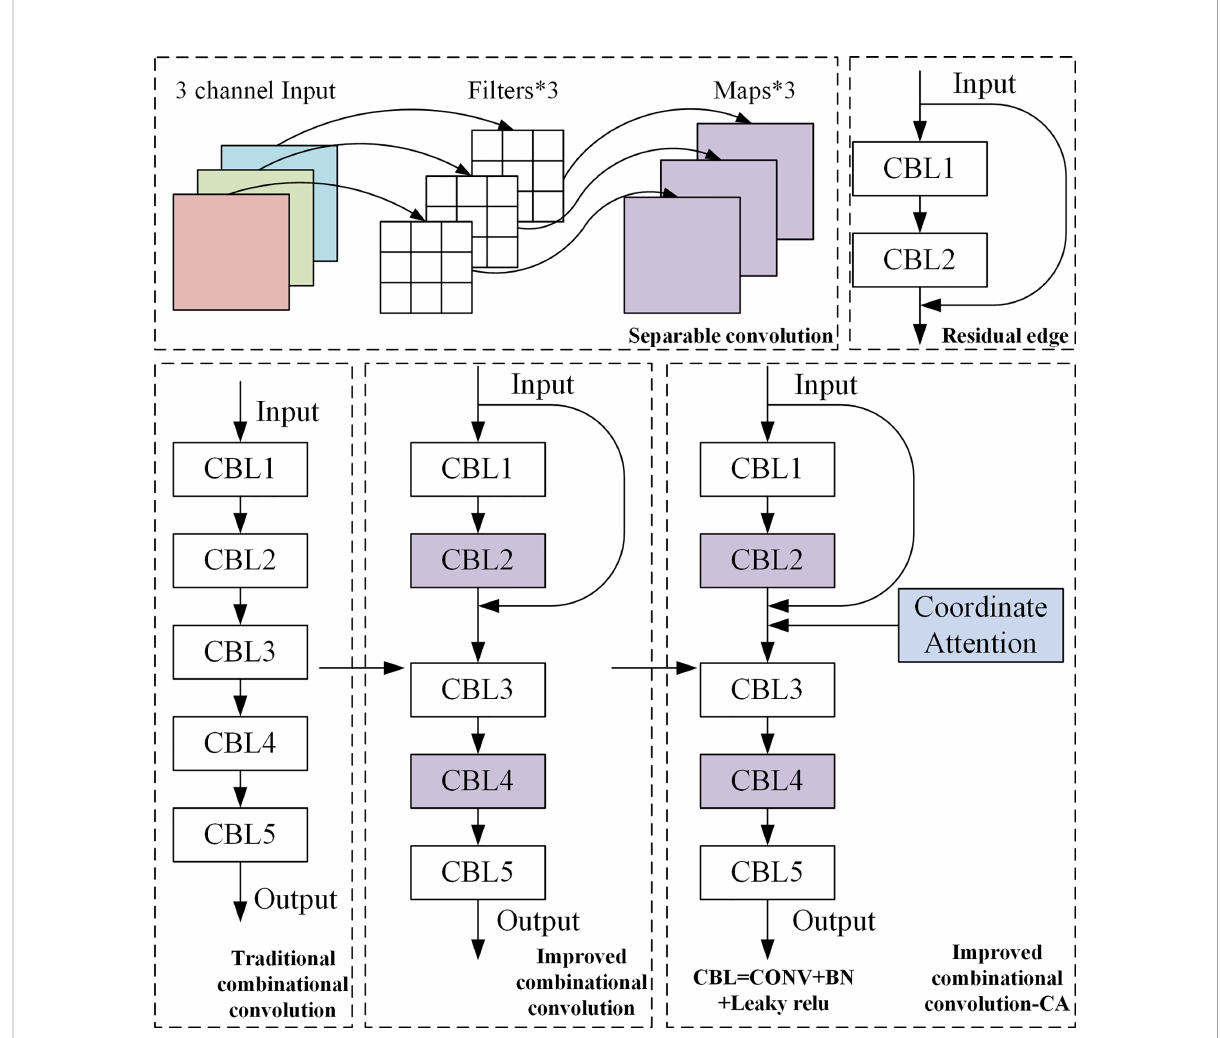
FIGURE 4 Structure diagram of improved combinational convolution-CA. * means repeat the